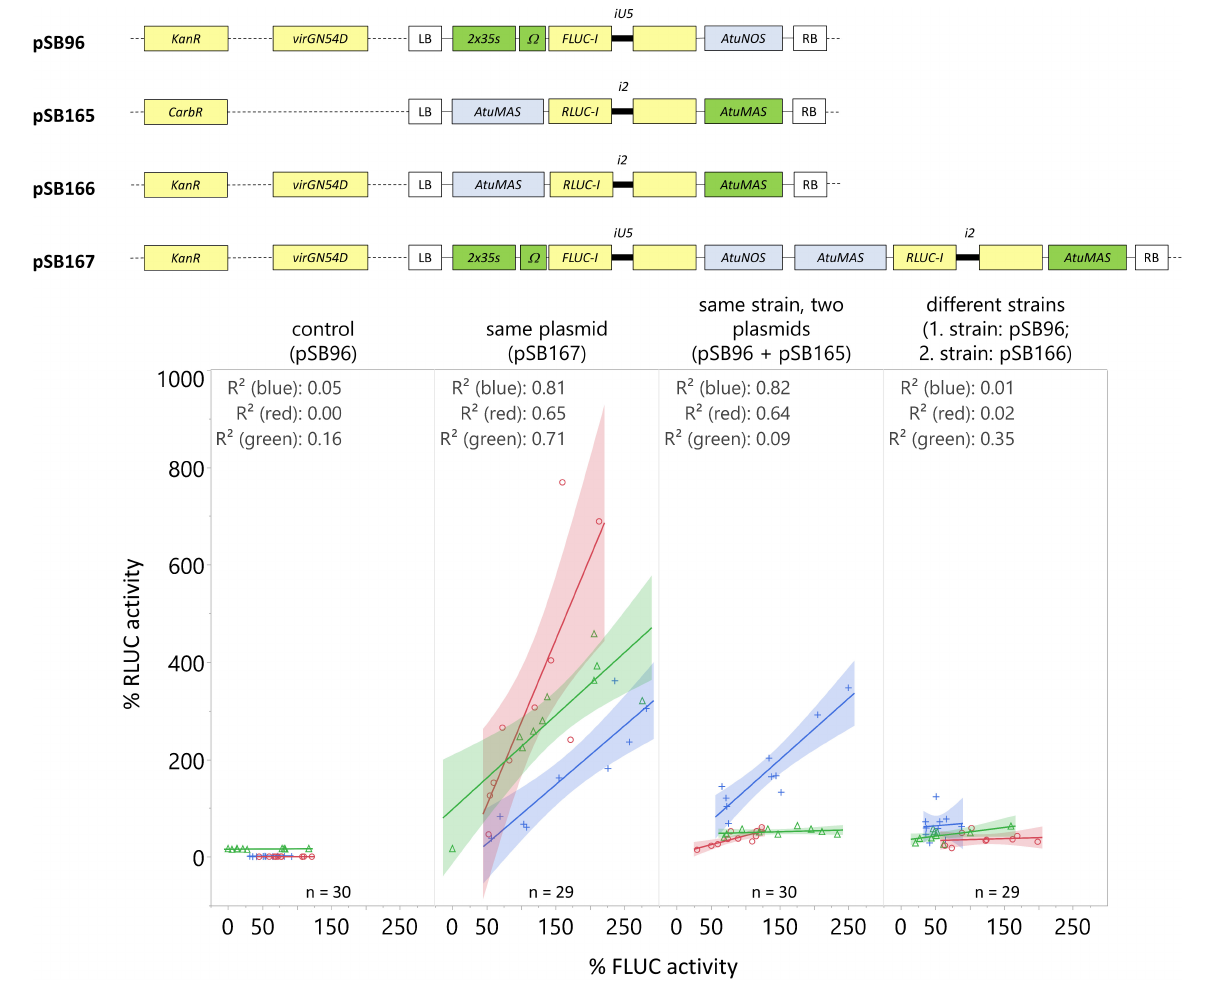
FIGURE 7 | Including the normalization reporter RLUC-I on the same plasmid as the reporter FLUC-I provides consistently high RLUC signal, and is highly correlated with FLUC signal. C. roseus seedlings (10-day-old) were vacuum infiltrated with A. tumefaciens containing: (I) the FLUC-I reporter (Negative control – pSB96), (II) the FLUC-I reporter and the RLUC-I reporter within the same plasmid (Same plasmid – pSB167), (III) the FLUC-I reporter and the RLUC-I reporter in different plasmids but same strain of A. tumefaciens (Same strain, Two plasmids – pSB96, pSB165), (IV) the FLUC-I reporter and the RLUC-I reporter in different plasmids and different strains of A. tumefaciens , co-infiltrated into seedlings (Different strains – pSB96, pSB166) at OD 600 = 0.2 for each strain. Samples were taken 3 dpi. The experiment was carried out in three independent assays (represented by blue, red, and green lines). For each independent assay, the FLUC activity of each sample was normalized to the average FLUC signal, and the RLUC activity of each sample was normalized to the average RLUC signal. Linear fit and corresponding R-squared values for the correlation between FLUC and RLUC signal are shown for each condition, in each experiment. The shaded region represents the 95% confidence interval of the linear